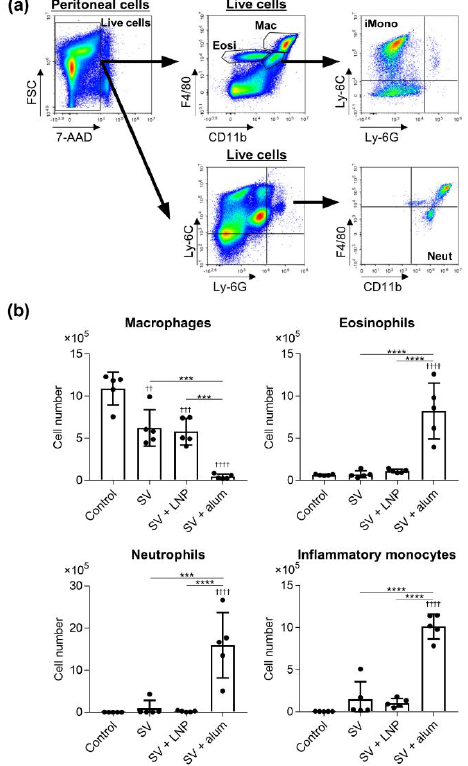
Figure 8. Recruitment of inflammatory immune cells by the LNP and alum in vivo. Mice were treated intraperitoneally with the SV alone, SV plus LNP, or SV plus alum. ( a , b ) After 20 h, the numbers of macrophages, eosinophils, neutrophils, and inflammatory monocytes in peritoneal lavage fluid were analyzed by flow cytometry. Gating schema for macrophages (Mac), eosinophils (Eosi), neutrophils (Neut), and inflammatory monocytes (iMono) are shown in ( a ). n = 5 per group. Data are means ± SD. †† p < 0.01, ††† p < 0.001, and †††† p < 0.0001 vs. untreated control group; *** p < 0.001 and **** p < 0.0001, as indicated by Tukey’s